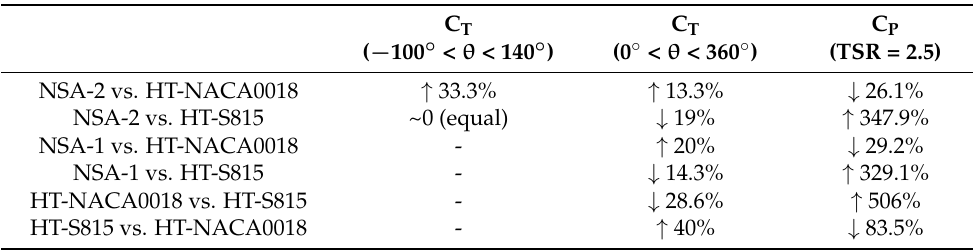
Table 2. Performance